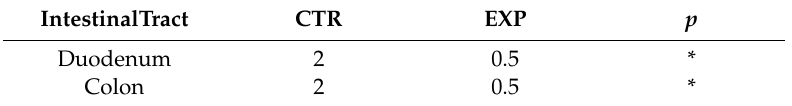
Figure 4. Immunohistochemical reactivity of swine gut. DAB staining is evident in the mucosal intestinal glands of the duodenum ( a , c ) and colon ( b , d ) and in some duodenal gland cells of the submucosal layer (inserts). Image shows stronger immunohistochemical staining in the CTR group ( a , b ) than the EXP group ( c , d ). Table 6. Intensity of BAX staining in tissue